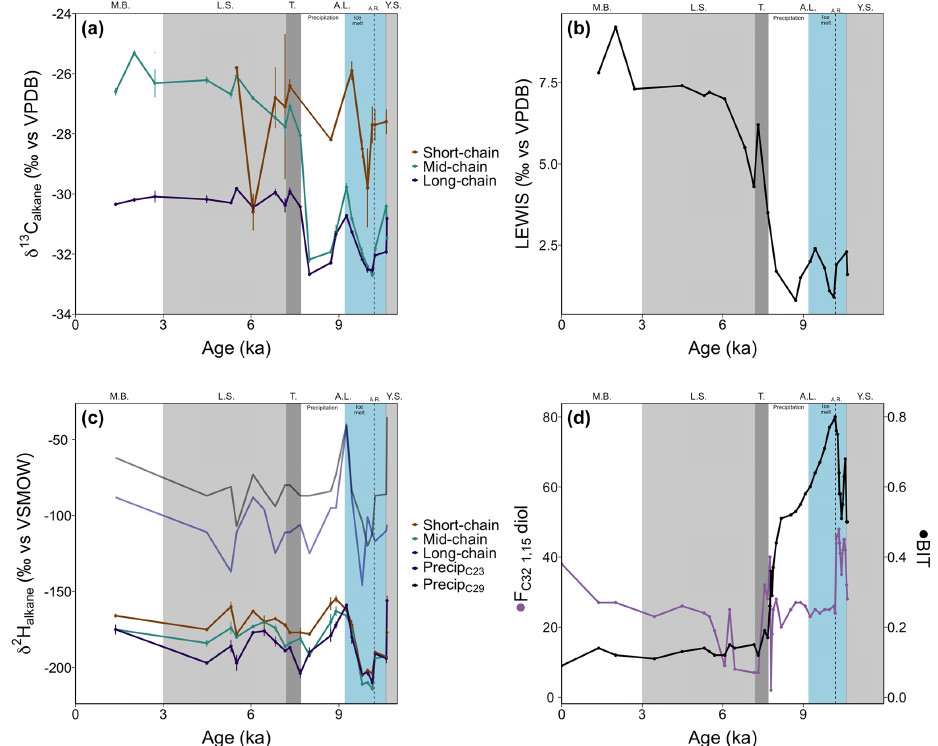
Figure 5. (a) Carbon isotope ratios of short-chain (C 21 ), mid-chain (C 23 –C 25 ), and long-chain (C 27 –C 31 ) n -alkanes from core 64PE410_S7. (b) Hydrogen isotope ratios of short-chain, mid-chain, and long-chain C 21 –C 33 n -alkanes from core 64PE410_S7. Blue and black lines represent reconstructed δ 2 H values of precipitation from linear models of McFarlin et al. (2019) using δ 2 H values of C 23 and C 29 n -alkanes. (c) The LEaf-Wax Isotopic Spread (LEWIS) index (Magill et al., 2019) shows a marked increase from the end of the Ancylus Lake phase into the modern Baltic indicating increased species diversity in the younger half of the record. (d) Fractional abundance of C 32 1,15-diol (F C321,15-diol , de Bar et al., 2016; Lattaud et al., 2017) and BIT index (Hopmans et al., 2004) for core 64PE410_S7, indicators of riverine and terrestrial runoff into the basin, suggest the highest terrestrial input occurred during the Ancylus Lake phase and decreased thereafter. Phase boundaries are indicated as well as a regional climate event at 10.2ka (A.R.: Ancylus Regression) and new subdivisions for the A.L. phase are shown in blue and